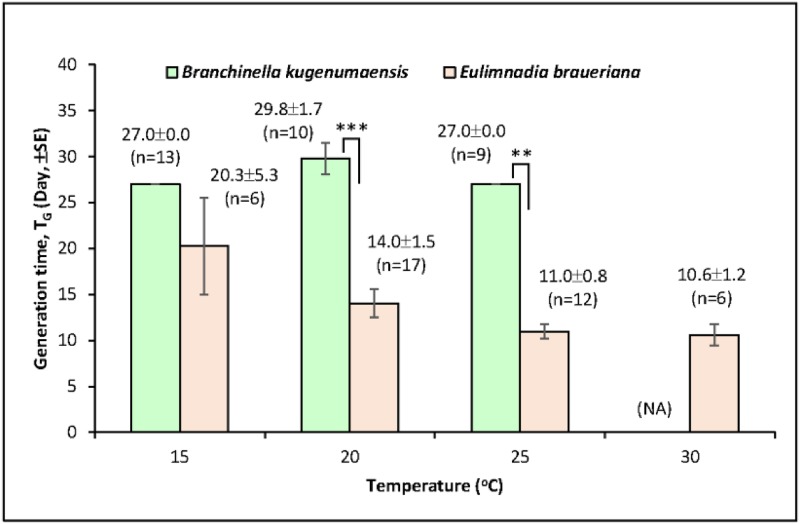
Generation times (TG) at different temperatures from B. kugenumaensis and E. braueriana.The symbol star (*) indicated significant difference of TG between B. kugenumaensis and E. braueriana (**p < 0.010, ***p < 0.001).